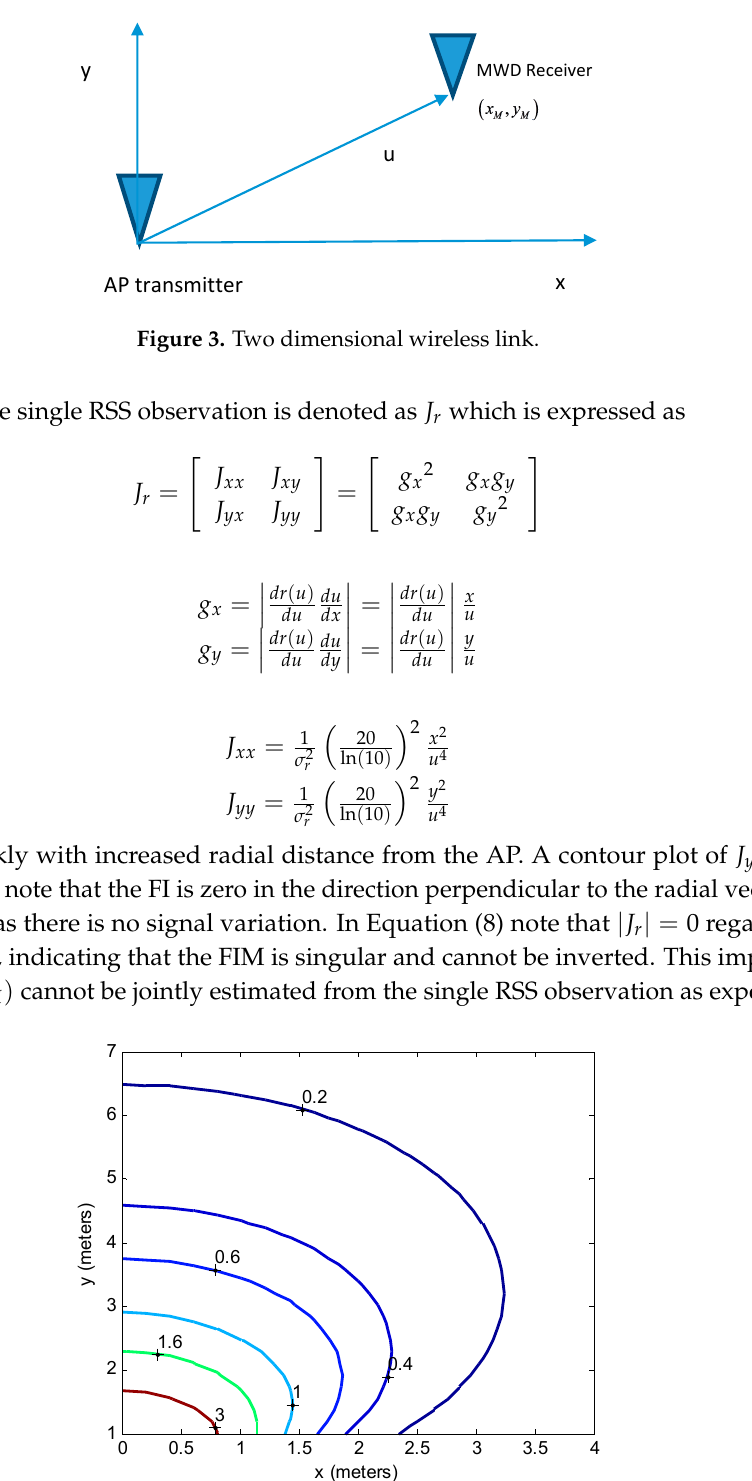
Figure 2. Fisher Information of a single RSS observation with